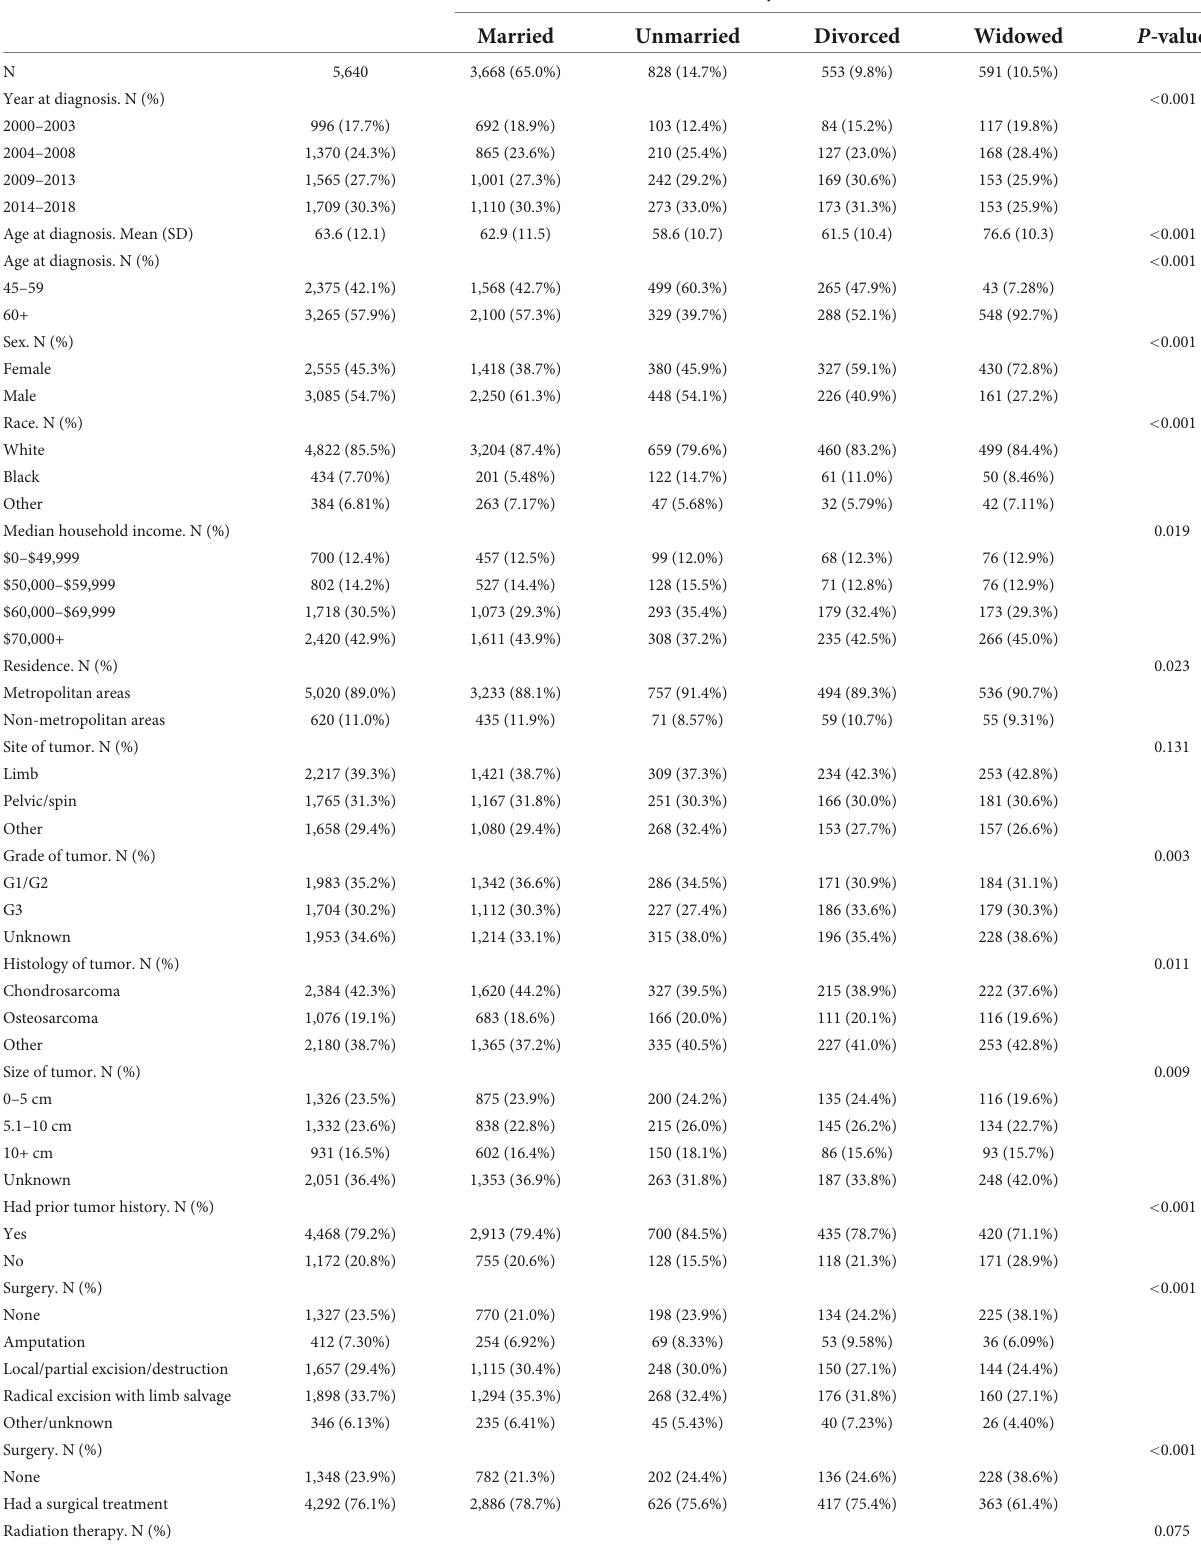
TABLE 1 Demographic and clinic characteristics for patients with bone cancer as the primary malignant tumor between 2000 and 2018.